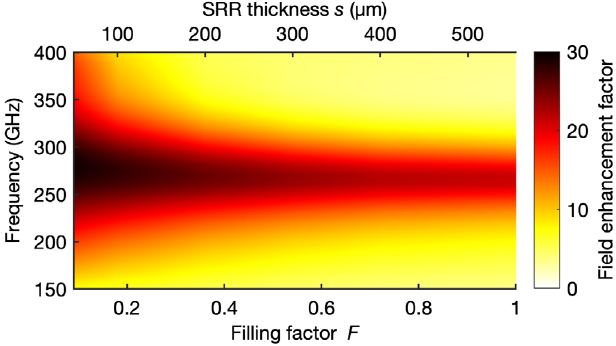
FIG. 3. Color-coded field enhancement j η ð ω Þj as a function of frequency and filling factor for a SRR array with a fixed distance of d ¼ 555 μ